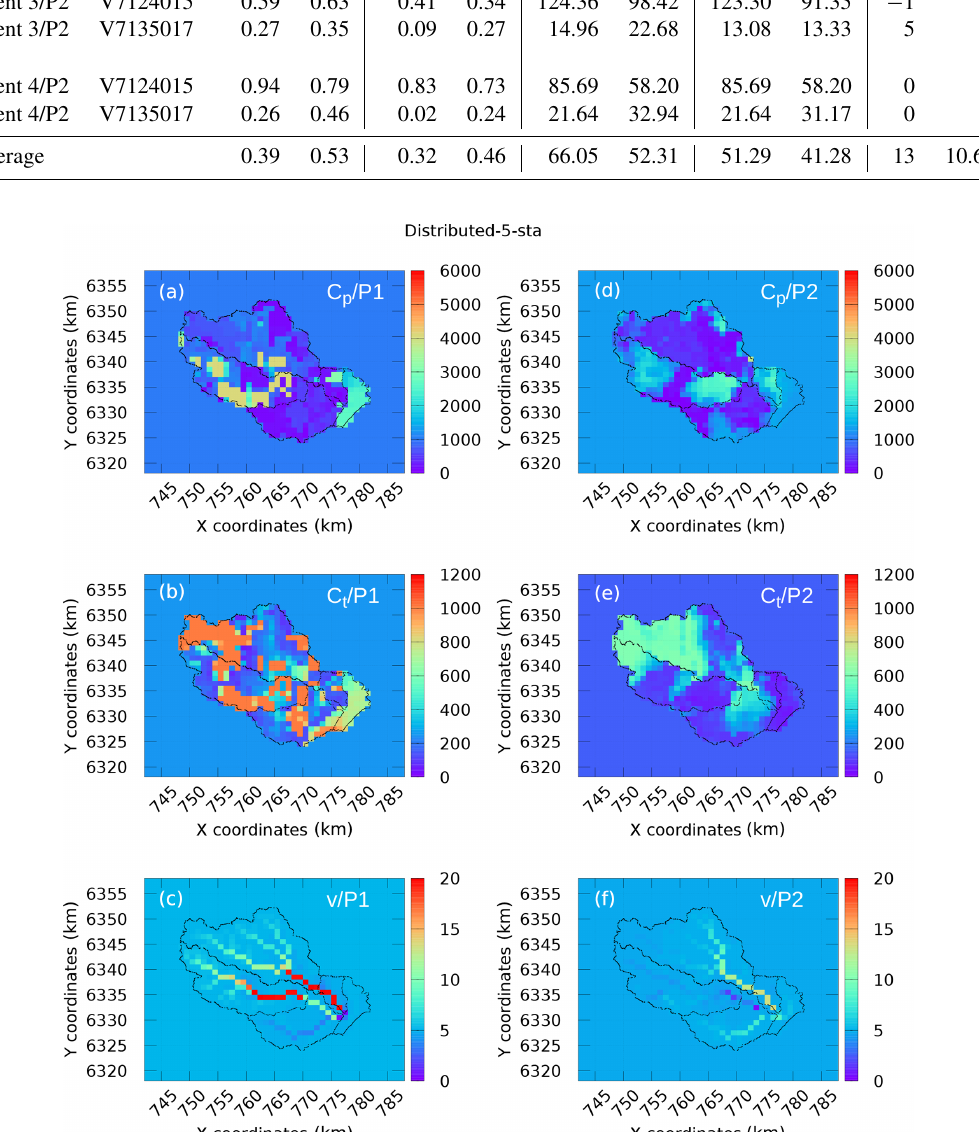
Figure 6. Maps of the calibrated coefficients (experiment 1 and 5-sta): (a–c) data from P 1 and (d–f) data from P